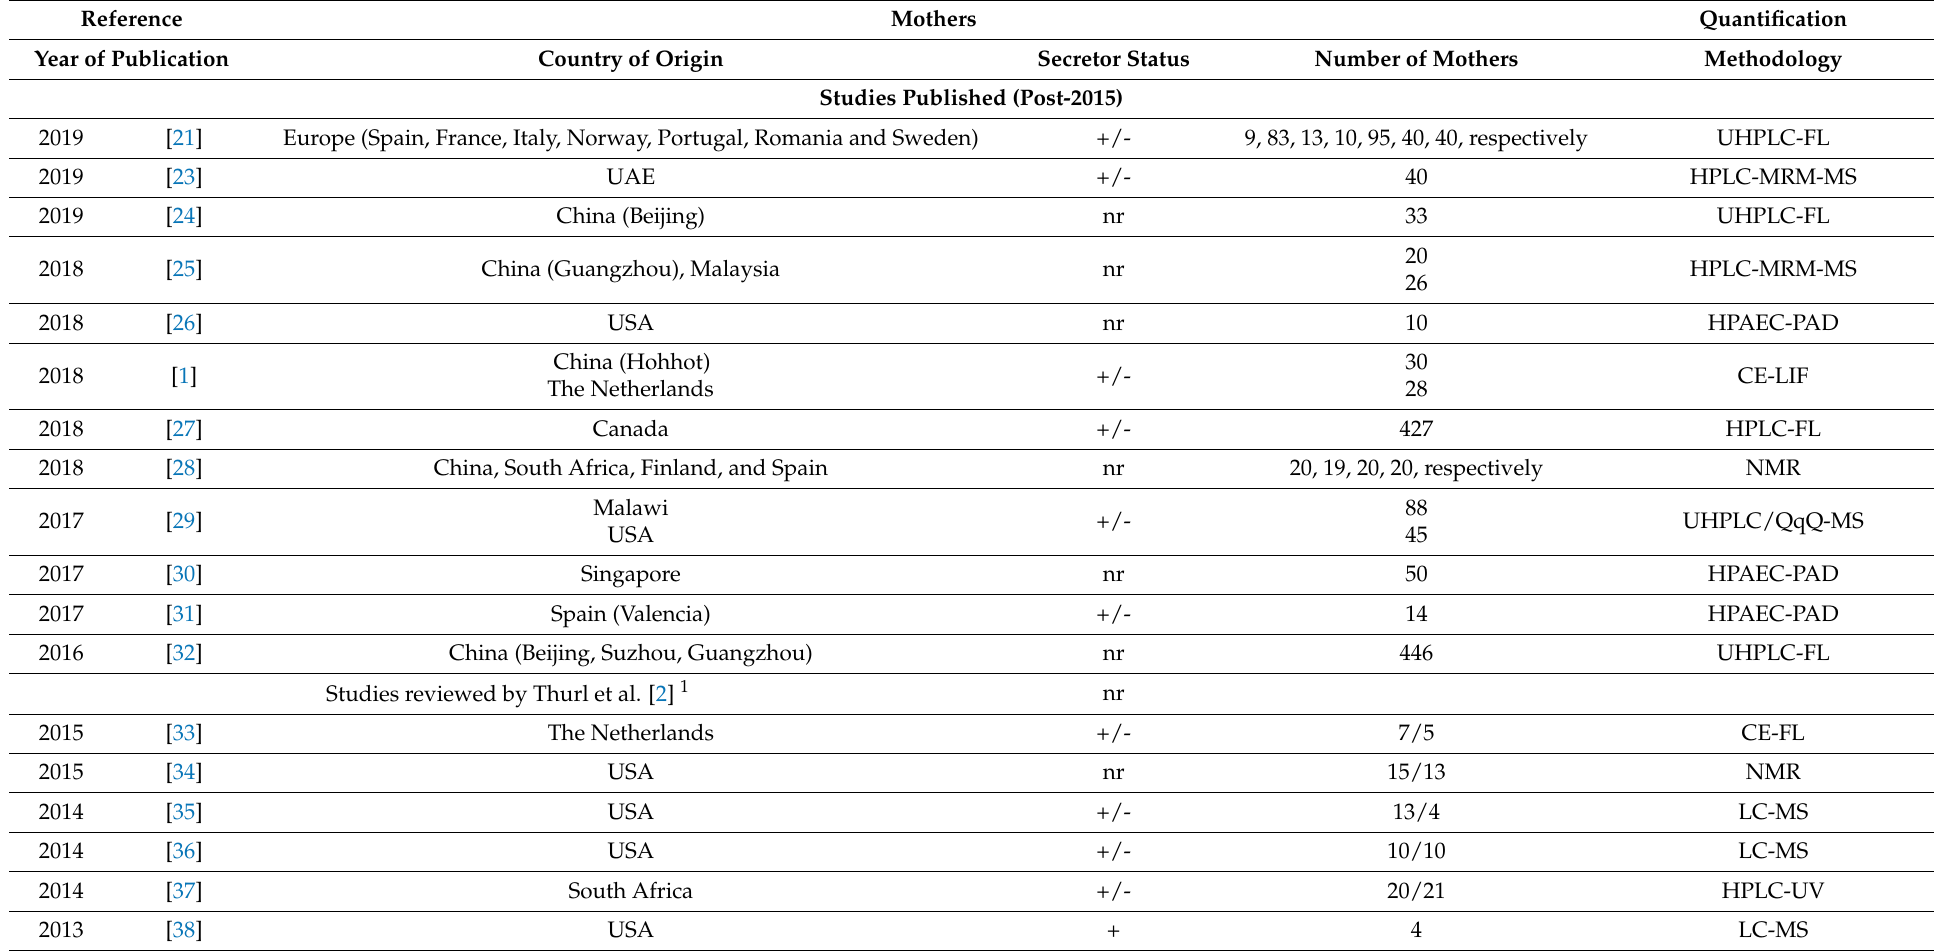
Table 2. Studies on human milk oligosaccharides composition examined in this